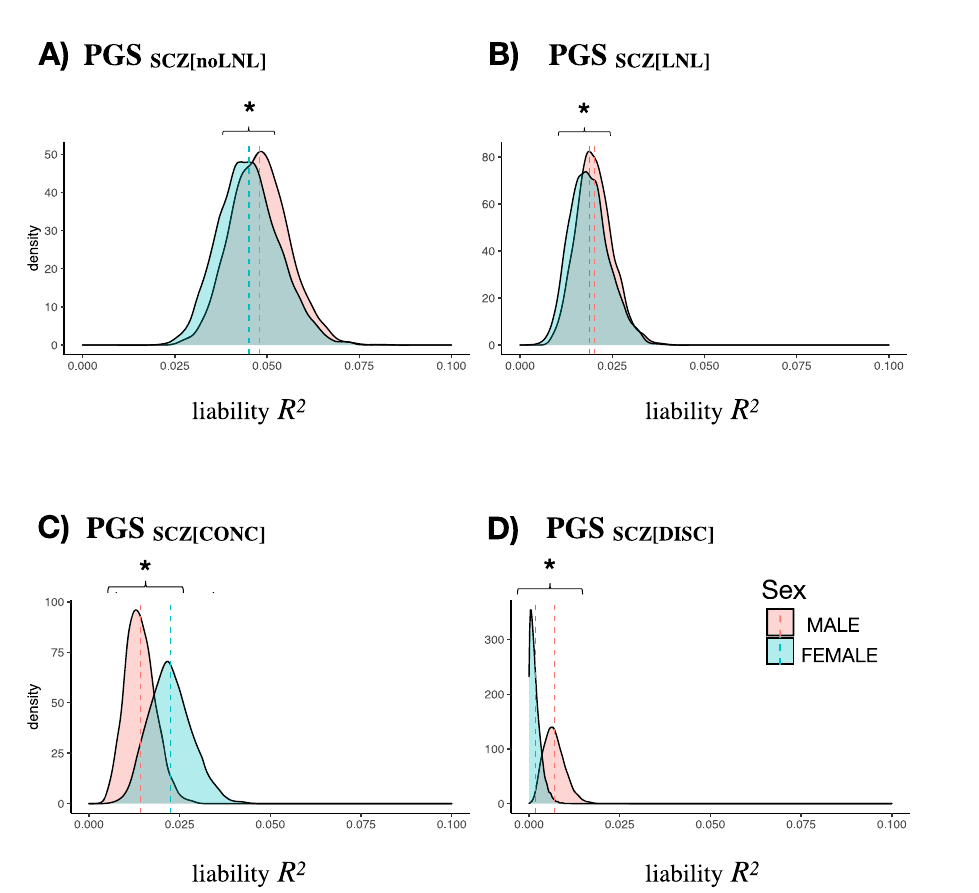
Fig. 3 Density plot for sex comparison of PGS SCZ contributions to schizophrenia risk. PGS SCZ predictions in case-control subsamples after bootstrap resampling (5000 permutations) of 500 schizophrenia patients (SCZ) and 500 healthy controls (HC) (selected from the overall CIBERSAM case-control sample) were performed in males (N SCZ = 1253; N HC = 859) and females (N SCZ = 674; N HC = 702), separately. Mean SCZ-HC variance explained by PGS SCZ on the liability scale (estimated prevalence of 0.01) in males and females was compared for predisposing variation within genome partitions. Variance explained in females and males was statistically compared with two-sided t-tests and is marked with an asterisk when it is signi fi cantly different ( p < 0.05). A PGS SCZ predictions comparison from variants within SCZ[noLNL]. B PGS SCZ predictions comparison from variants within SCZ[LNL]. C PGS SCZ predictions comparison from variants within SCZ[CONC]. D PGS SCZ predictions comparison from variants within